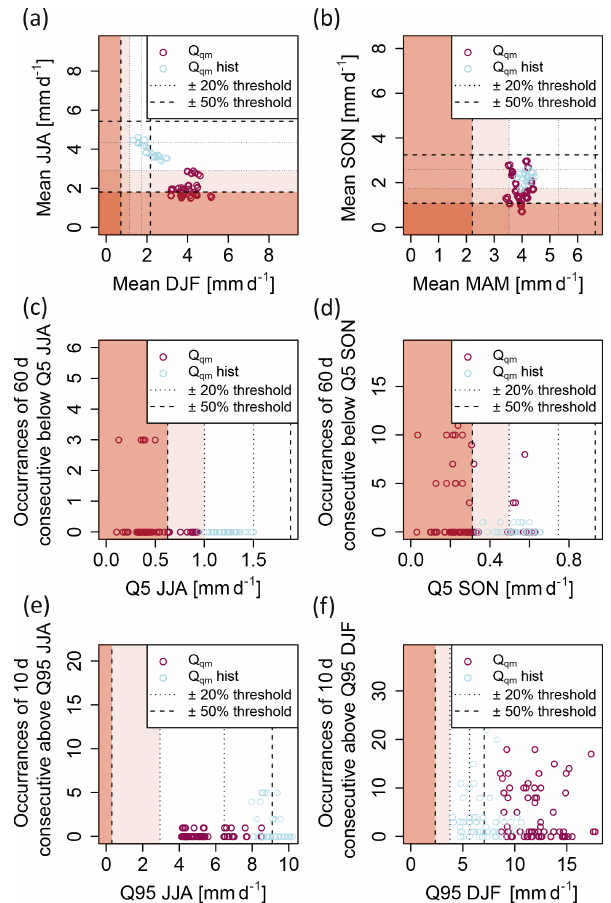
Figure 8. Situations leading to the greatest stress on Groupe E’s operations are depicted by the comparisons of low-flow, high-flow, and seasonal-flow indices for the Vernex catchment. Two time pe- riods are compared in the left and right columns: (a–c) 1980–2009 and (d–f) 2070–2099. Panels (d–f) show simulations under the in- fluence of RCP8.5. Panels (a) and (b) depict seasonal flows: mean winter flow (DJF) versus mean summer flow (JJA). Panels (c) and (d) depict low flows: Q5 summer flows (JJA) versus the occurrence of consecutive days below Q5. Panels (e) and (f) depict high flows: Q95 winter flows (DJF) versus the occurrence of consecutive days above Q95. For all plots, two thresholds, which were provided by Groupe E, are included: ± 20% and ± 50%. Shading from white to progressively darker red tones indicates the lowest (white) to high- est (dark red) levels of stress placed on Groupe E’s operations based on the relationship between the